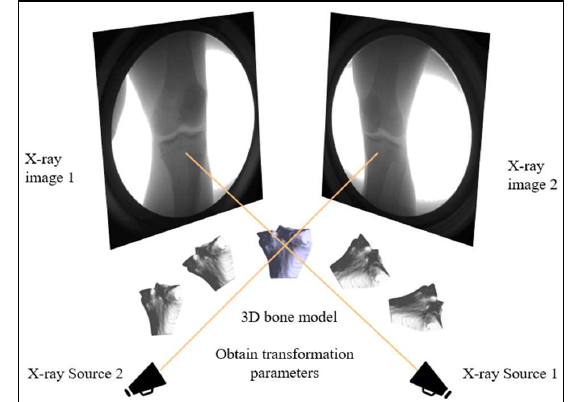
Figure 2. Illustration of the transformation parameter